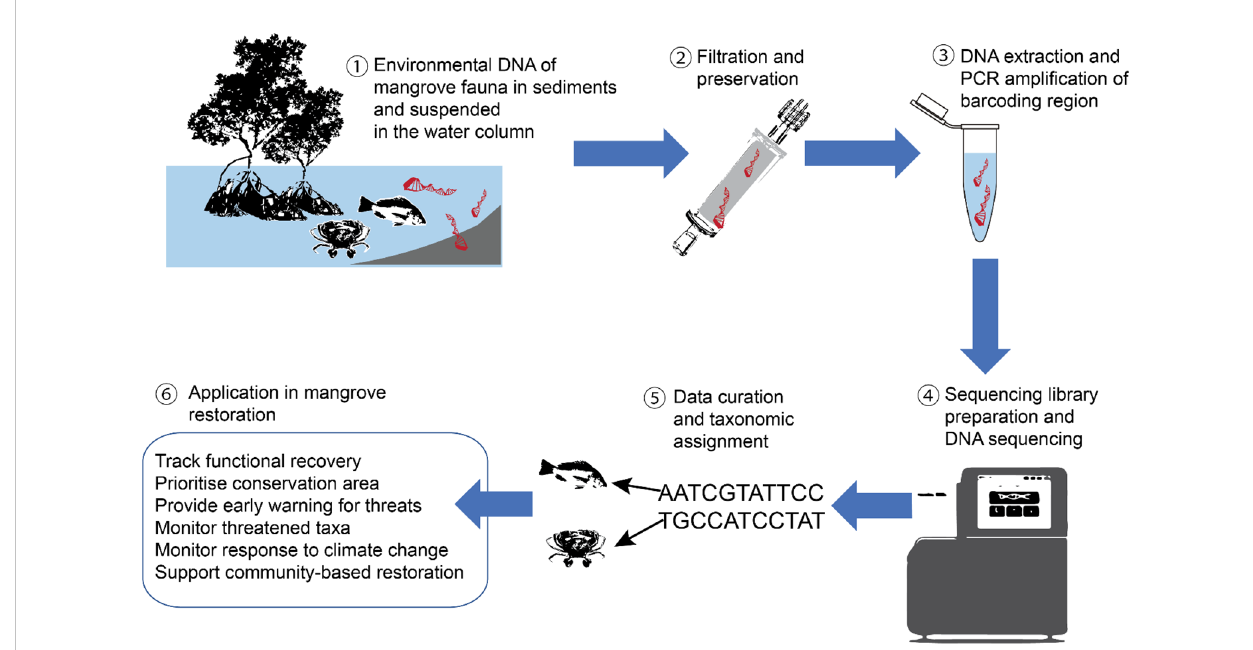
FIGURE 1 Work fl ow and potential applications of eDNA metabarcoding in